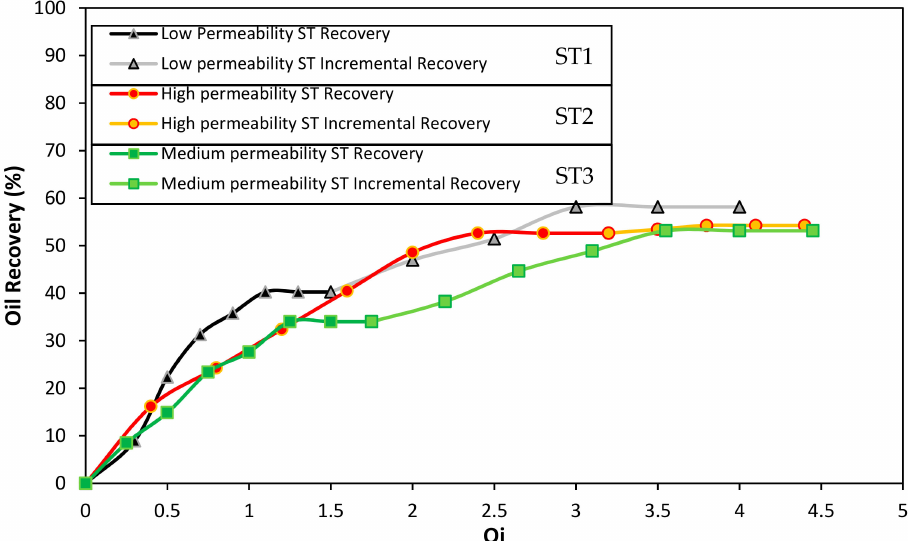
Figure 8. Oil recovery through waterflooding before and after the injection of the best gel obtained. The porous medium is composed of Ottawa sand mesh sizes 8–20 (17%), 40–70 (50%), and 100–200 (33%) for the low permeability slim tube (ST1), 20–40 (100%) for the high permeability sand pack (ST2), and 8–20 (10%), 40–70 (60%), and 100–200 (30%) for the medium permeability slim tube (ST3). Waterflooding before and after the gel injection was made with a 7000 mg / L of NaCl brine. The gel systems consisted of 4000 mg · L − 1 of Acrylamide Sodium Acrylate / Chromium (III) Acetate in p / c ratio of 40:1 in the presence of 100 mg · L − 1 of Cr 2 O 3 nanoparticles. The test was performed at 60 ◦ C and 13.8 MPa of overburden